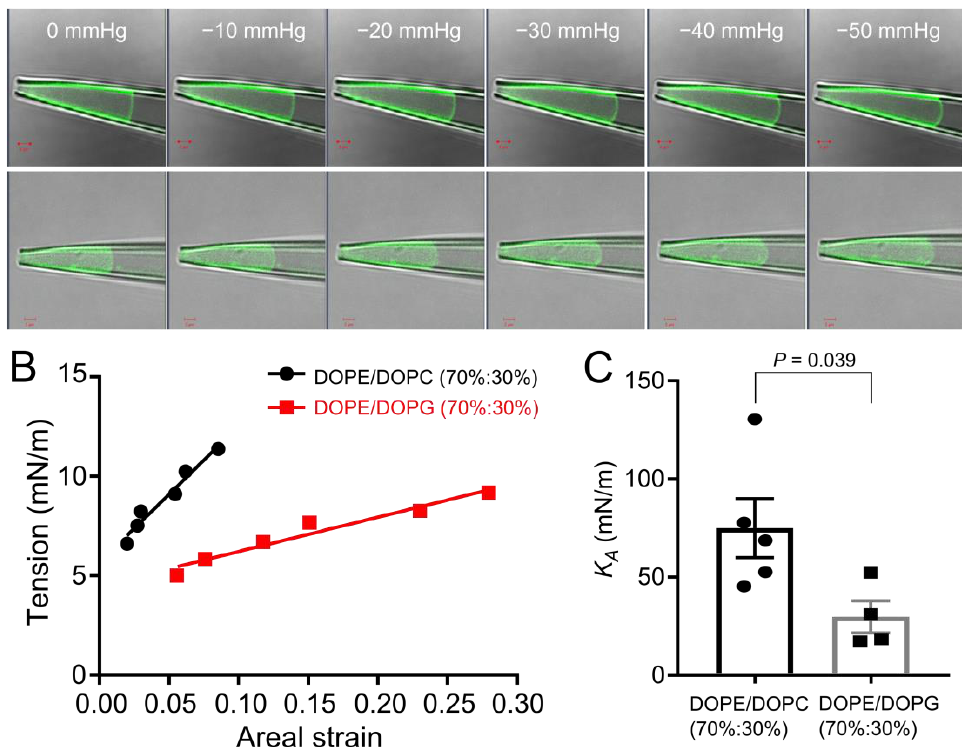
Figure 6. Evaluation of membrane stiffness by micropipette aspiration combined with patch fluo- rometry. ( A ) Fluorescent images of liposomal excised patch membranes under various pressures made of different synthetic lipids of DOPE/DOPC (70%:30%) (top) and DOPE/DOPG (70%:30%) (bottom). Scale bars show 2 μm. ( B ) Comparison of the slope of the membrane tension vs. areal strain between DOPE/DOPC (70%:30%) (black circles) and DOPE/DOPG (70%:30%) (red squares). ( C ) The areal elasticity modulus K A of DOPE/DOPC (70%:30%) (circles) ( n = 5) and DOPE/DOPG (70%:30%) (squares) ( n = 4). p -values were calculated by t -test (two-sample assuming unequal variances) to compare between two